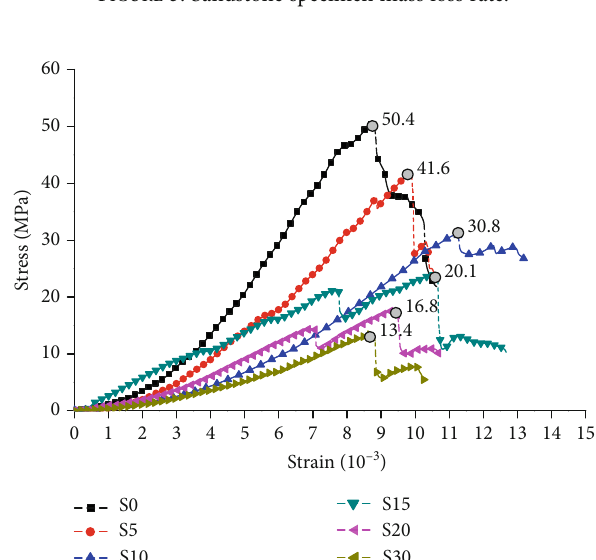
Figure 6: Stress-strain curves of sandstones with di ff erent salt damage erosion